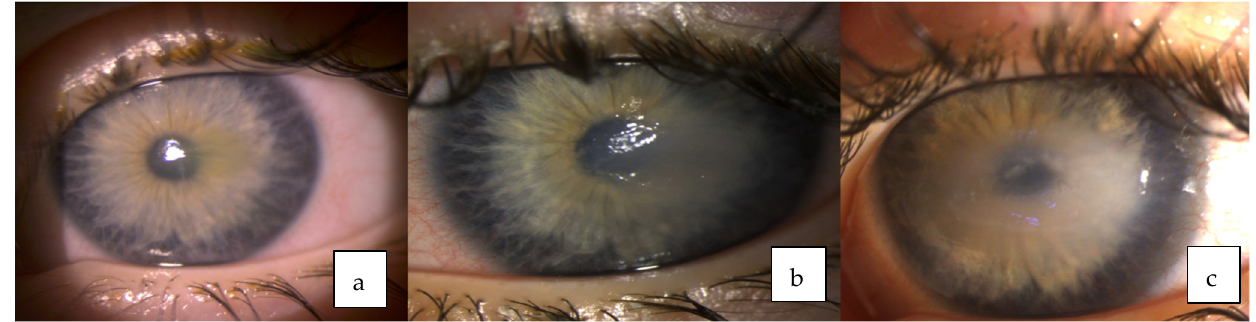
Figure 2. Dynamic of the left eye: ( a ) Central corneal erosion. ( b ) Superficial corneal ulcer. ( c ) Stromal corneal ulcer.